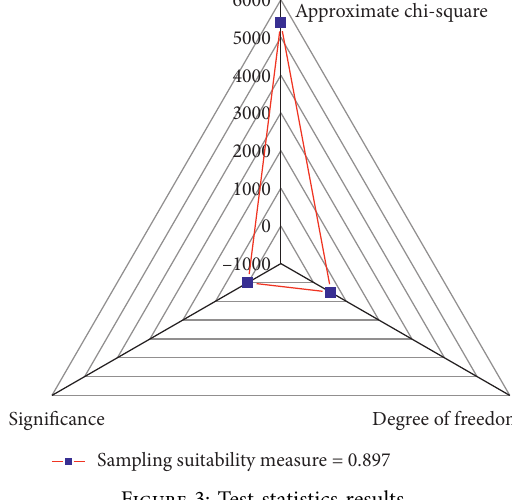
Figure 3: Test statistics results.